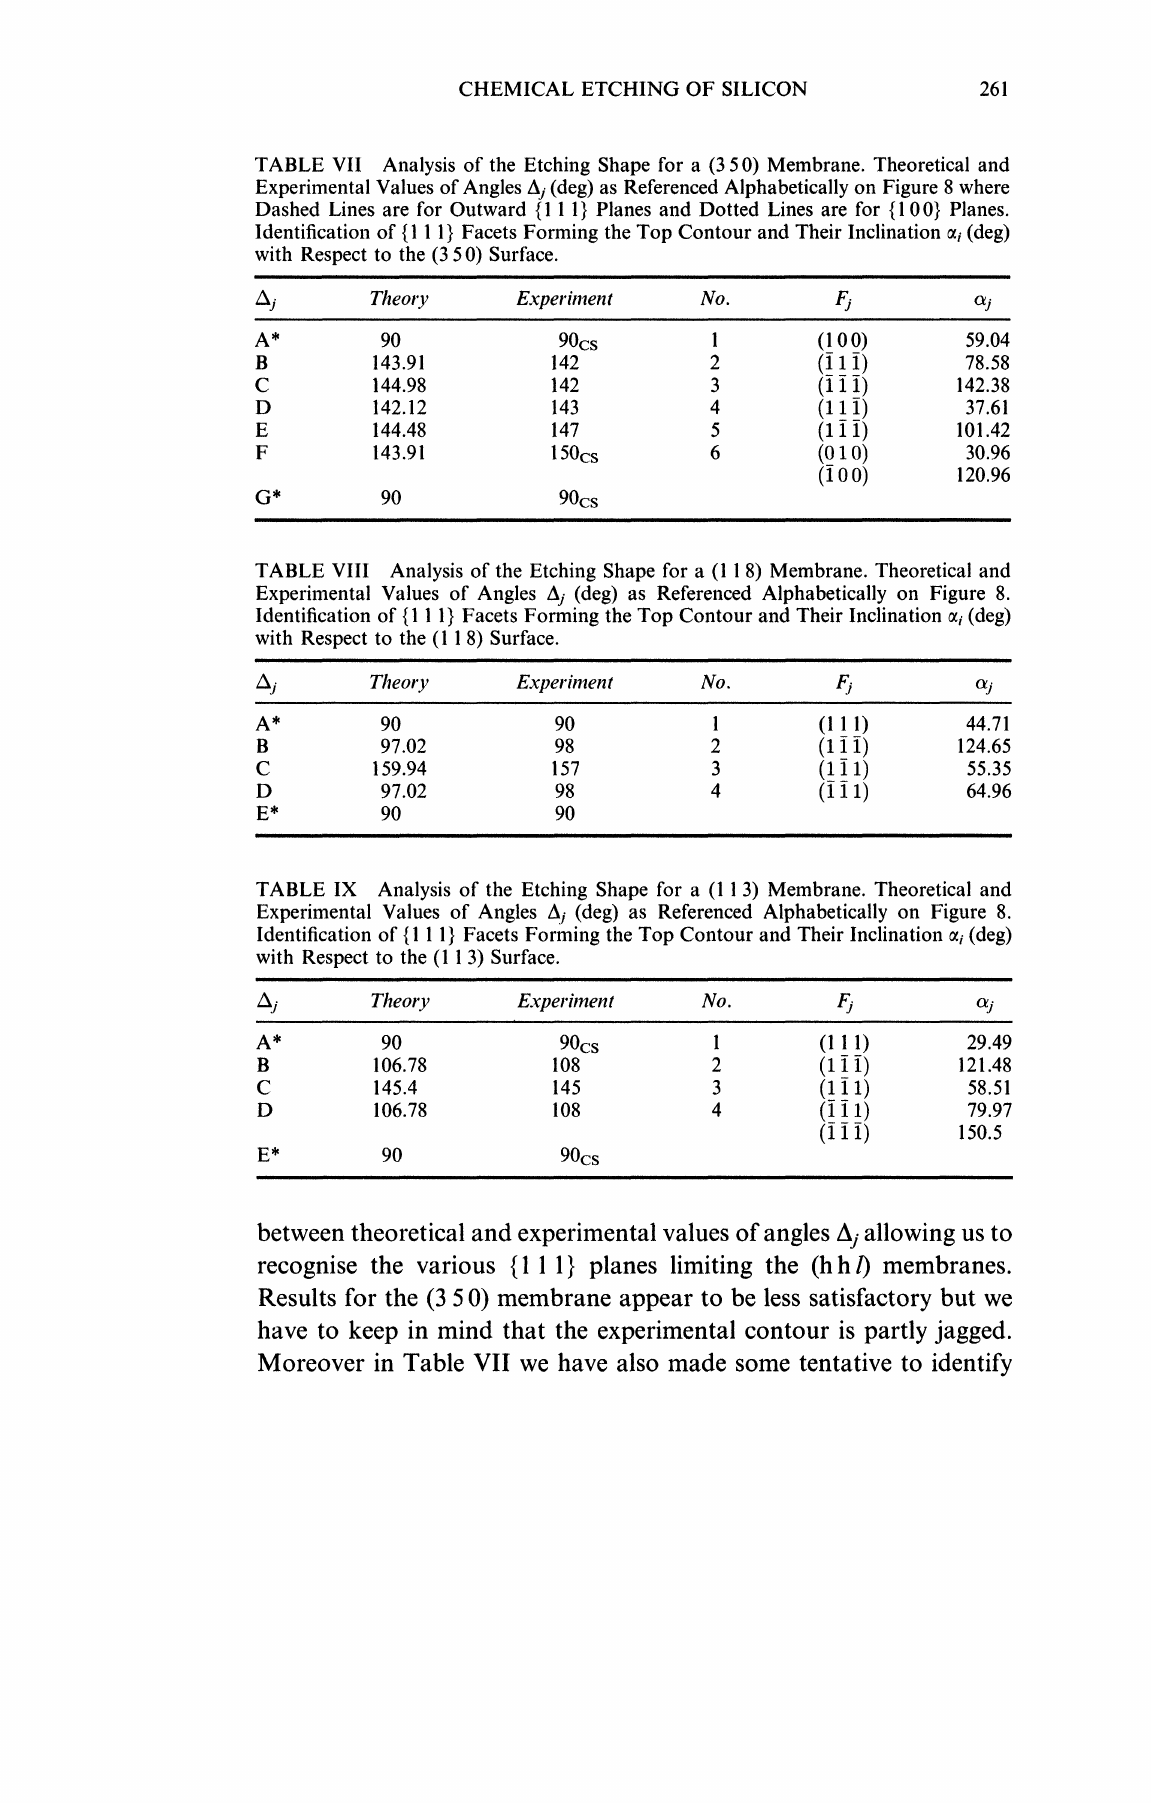
TABLE VII Analysis of the Etching Shape for a (3 50) Membrane. Theoretical and Experimental Values of Angles Aj (deg) as Referenced Alphabetically on Figure 8 where Dashed Lines are for Outward {1 1} Planes and Dotted Lines are for {1 00} Planes. Identification of